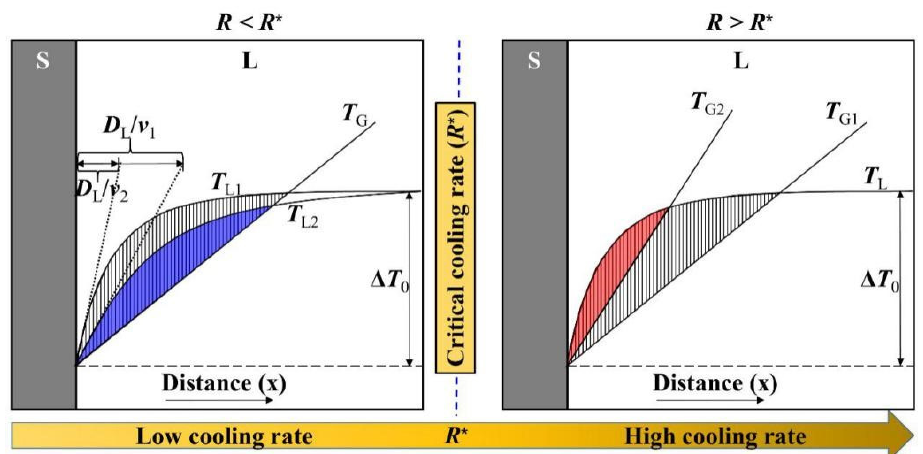
Figure 11. Schematic drawing representing the relationship between the cooling rate and the concentration undercooling formation ahead of the S/L interface.